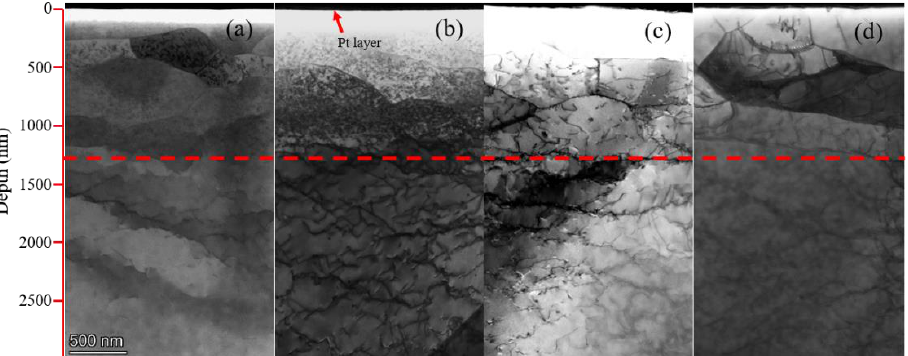
Figure 7. STEM bright-field micrographs showing the subgrains formed in Fe-Cr alloys; above the red lines are the irradiation damage regions: ( a ) Fe-9Cr-C irradiated at 450°C; ( b ) Fe-9Cr irradiated at 450°C; ( c ) Fe-9Cr irradiated at 550°C; ( d ) Fe-9Cr-C irradiated at 550°C.